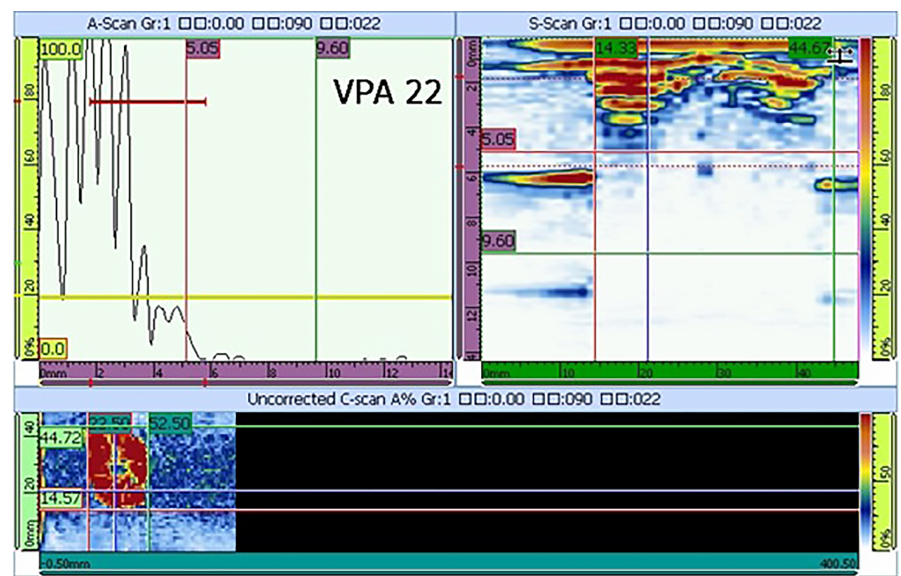
Figure 2. Typical C scan image of the delaminated plate (scan from the back of the